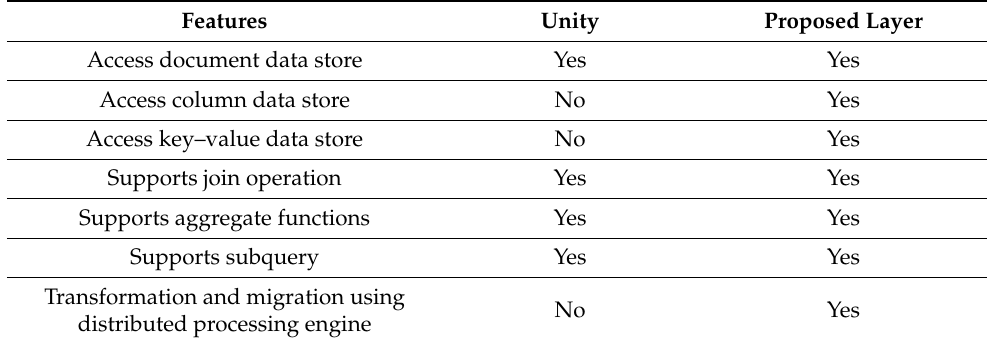
Table 6. Qualitative comparison between the proposed layer and Unity.